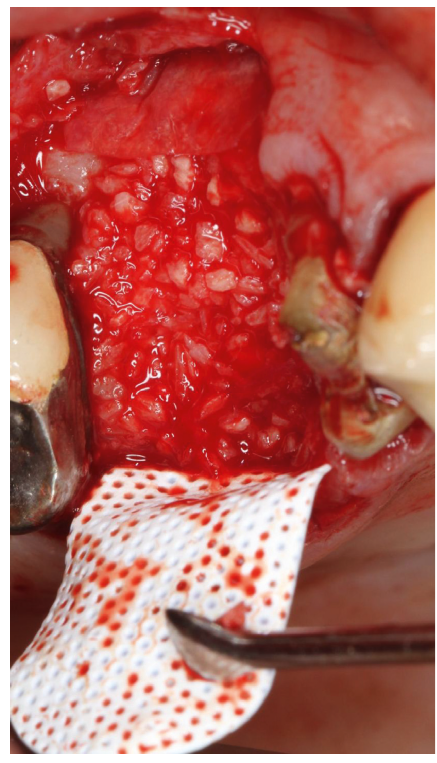
Figure 5: The collagen membrane was placed on the buccal aspect to cover the grafted buccal plate. The nonresorbable high density PTFE membrane was placed on the lingual aspect to cover the grafted